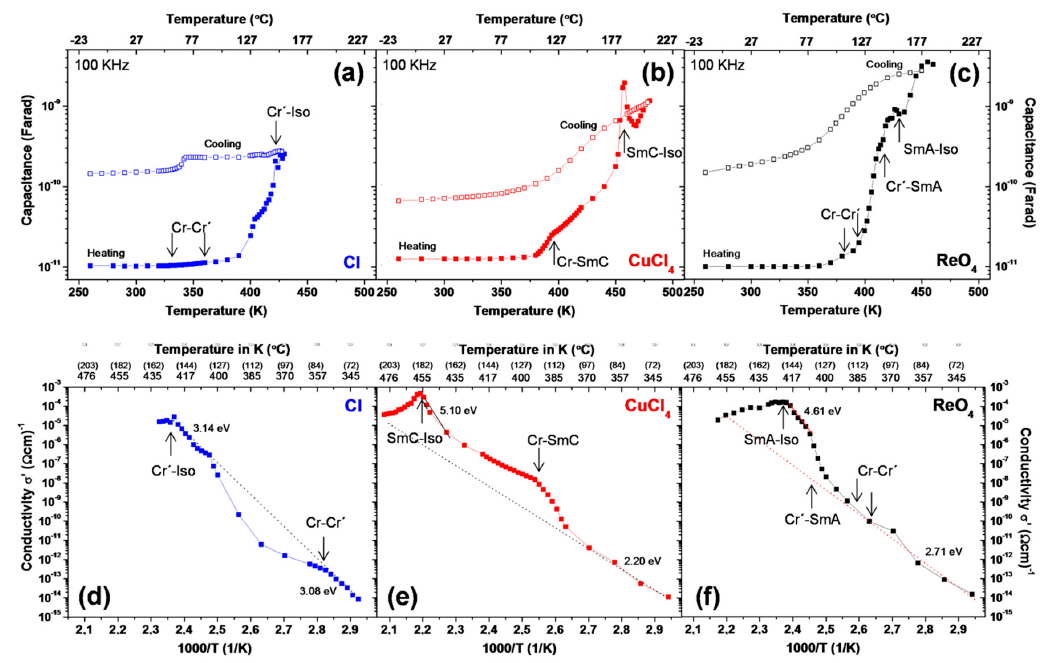
Figure 7. ( a – c ) C ′ vs. T and ( d – f ) σ ′ vs. f plots for the Cl − , CuCl 42 − and ReO 4 − - based compounds.